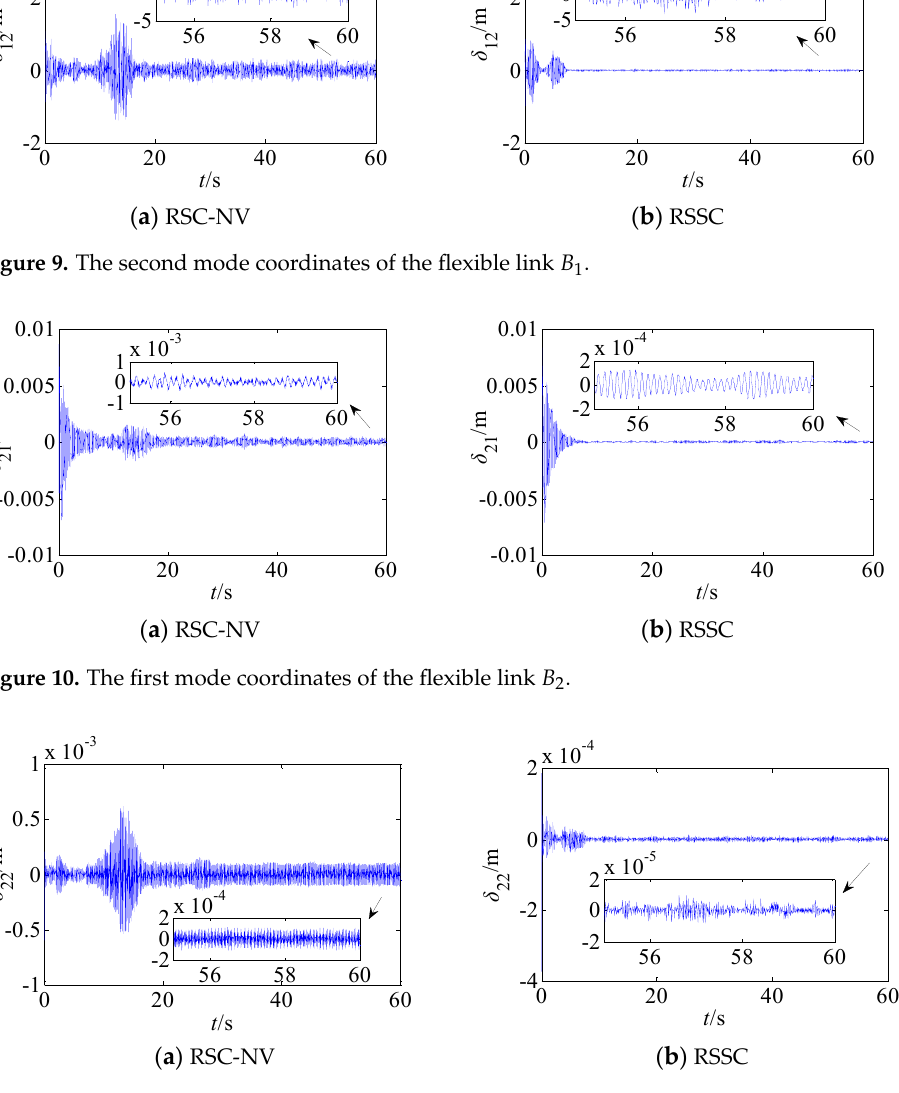
B . Figure 11. The second mode coordinates of the flexible link B 2 2